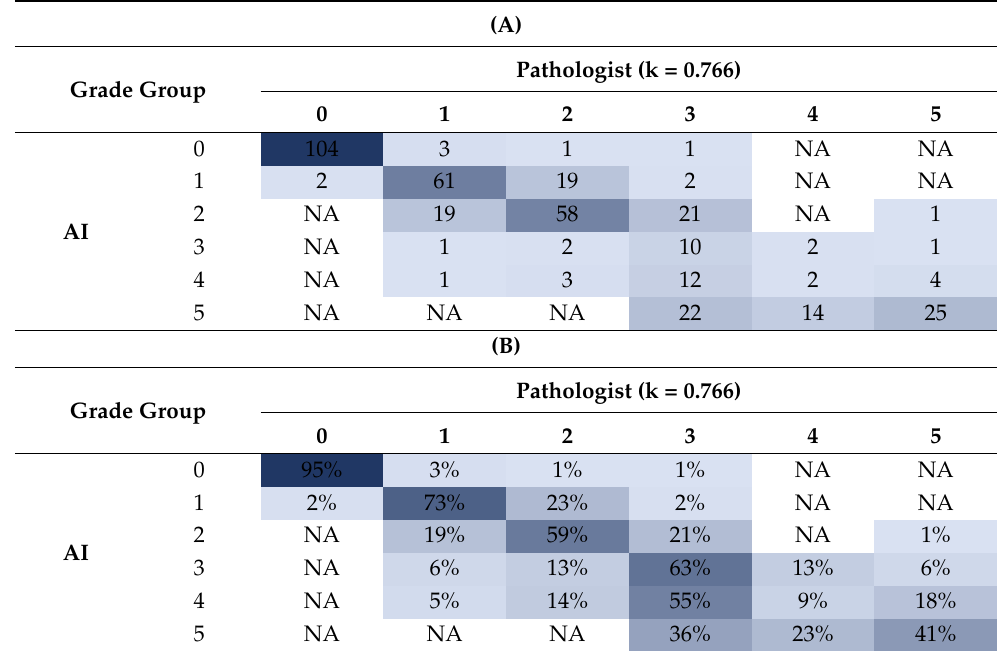
Table 4. Confusion matrix for the grade group in complete biopsy sessions by the pathologist versus AI. Distribution of patient-level grade groups ( A ). Percentage distribution ( B ).